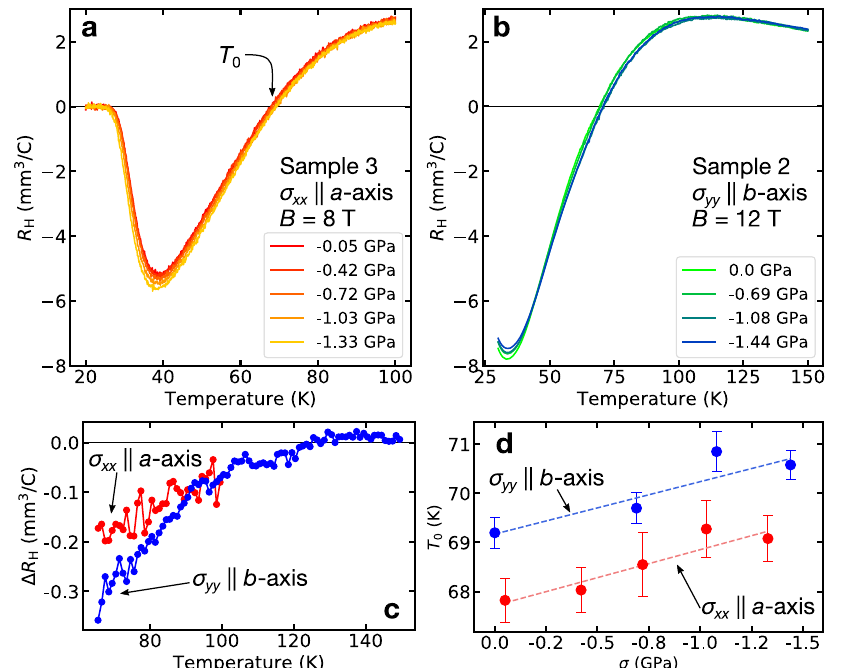
Fig. 4 Hall effect under uniaxial stress. Temperature dependence of the Hall coef fi cient in a magnetic fi eld of 8 T under uniaxial stress along the a -axis (panel a ) and in 12 T and along the b -axis (panel b ). The stress amplitudes are shown in the legend. Note that the upturn of R H upon cooling below ~40 K is due to the onset of superconductivity. c Difference between the Hall coef fi cients measured for σ ~ − 1 GPa and σ = 0. d Sign reversal temperature T 0 as a function of stress. The error bars are the standard deviations of T 0